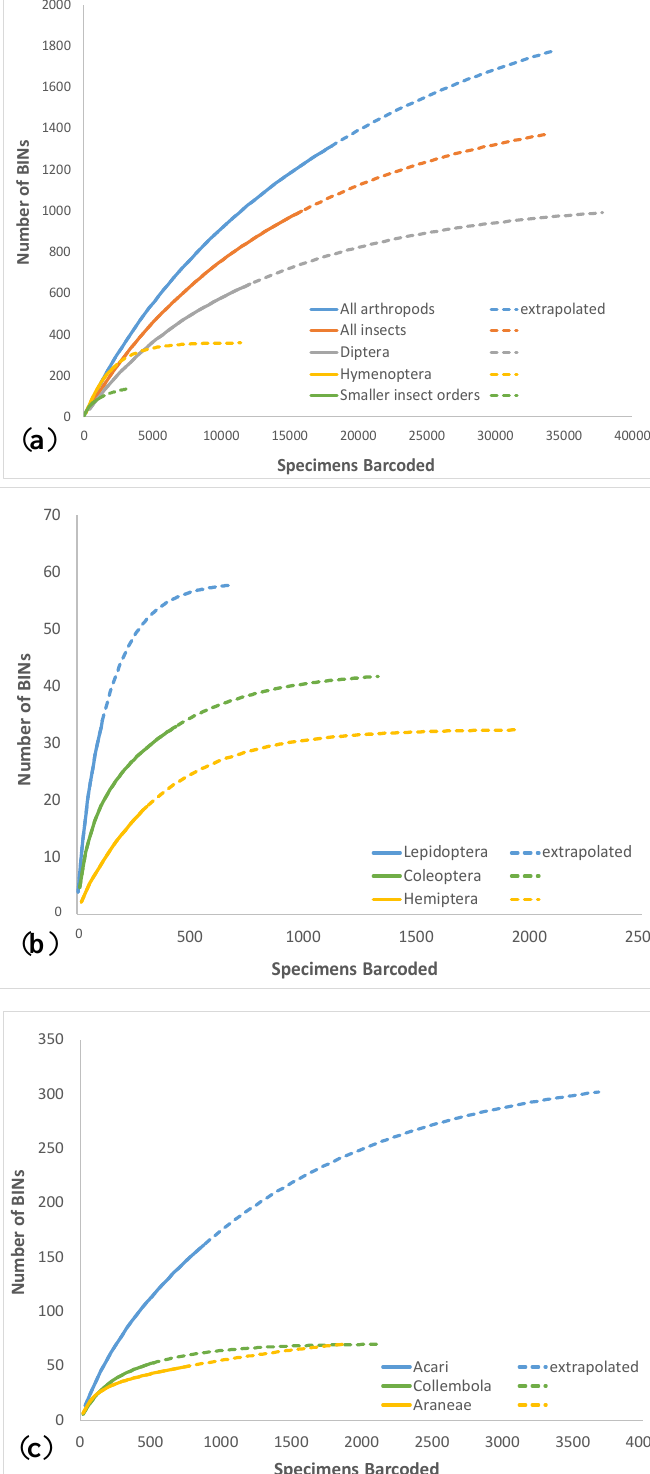
Figure 1. Estimated accumulation curve and overall taxonomic diversity assessment for all arthropods barcoded.